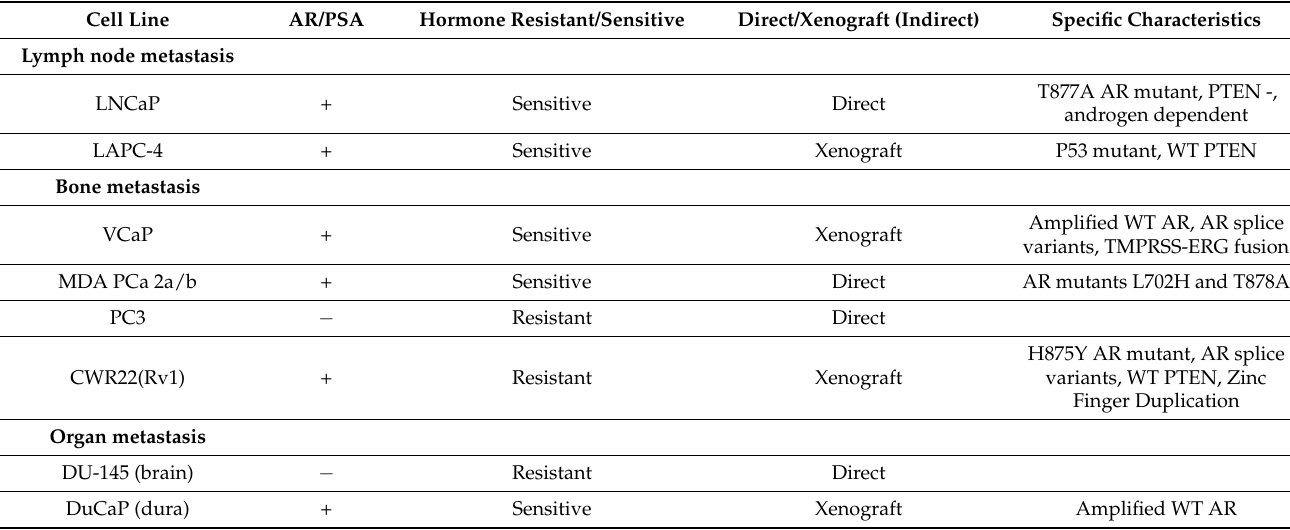
Table 1. Overview commonly used prostate cancer cell lines. Wild type (WT); androgen receptor (AR). Adapted from [6–8]. Cell